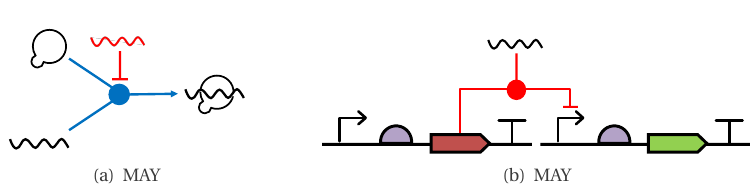
Section 4.3. Examples are provided in Figure 20.